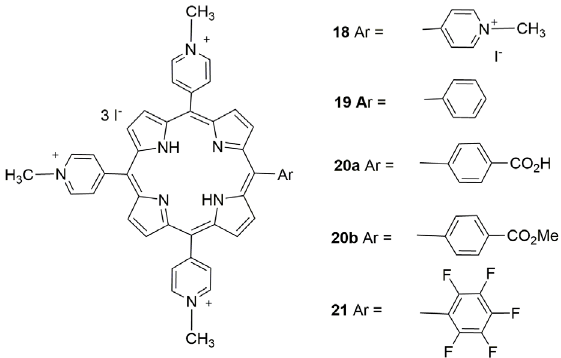
Figure 19 - Structures of cationic porphyrin derivatives 18 , 19 , 20a,b and 21